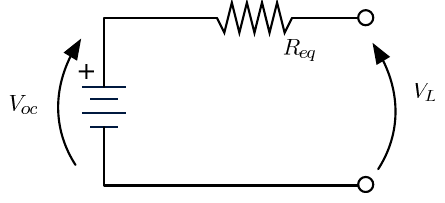
Figure 3. Zeroth order electrical circuit model of the battery.